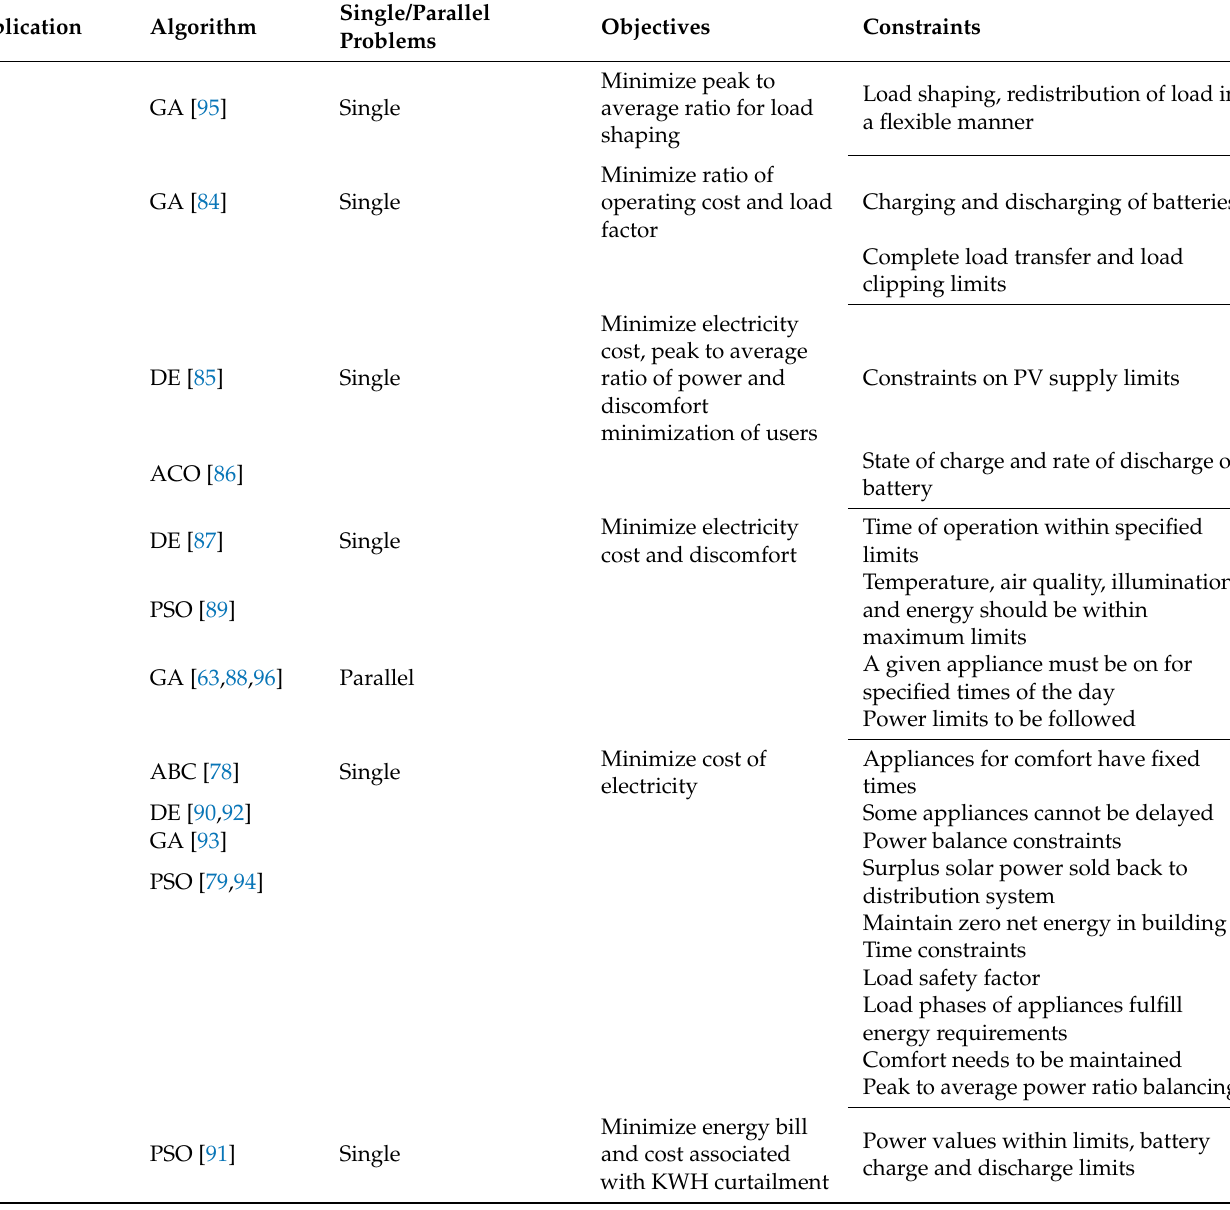
Table 10. Data setup used for Smart